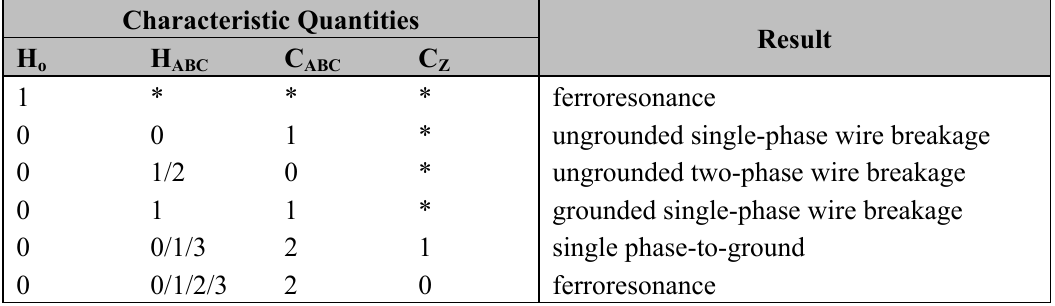
Table 2. Characteristic quantity for power frequency